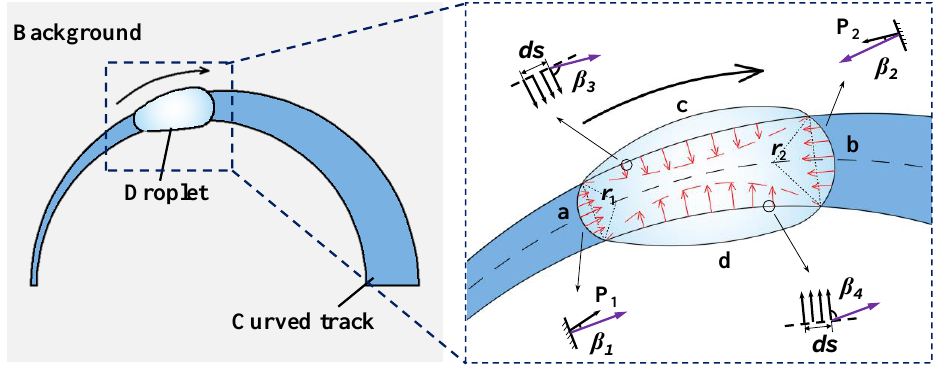
Figure 4. Theoretical model for motion of a droplet on the functional surface constituted by a gradually widening hydrophilic curved track and a hydrophobic surface.